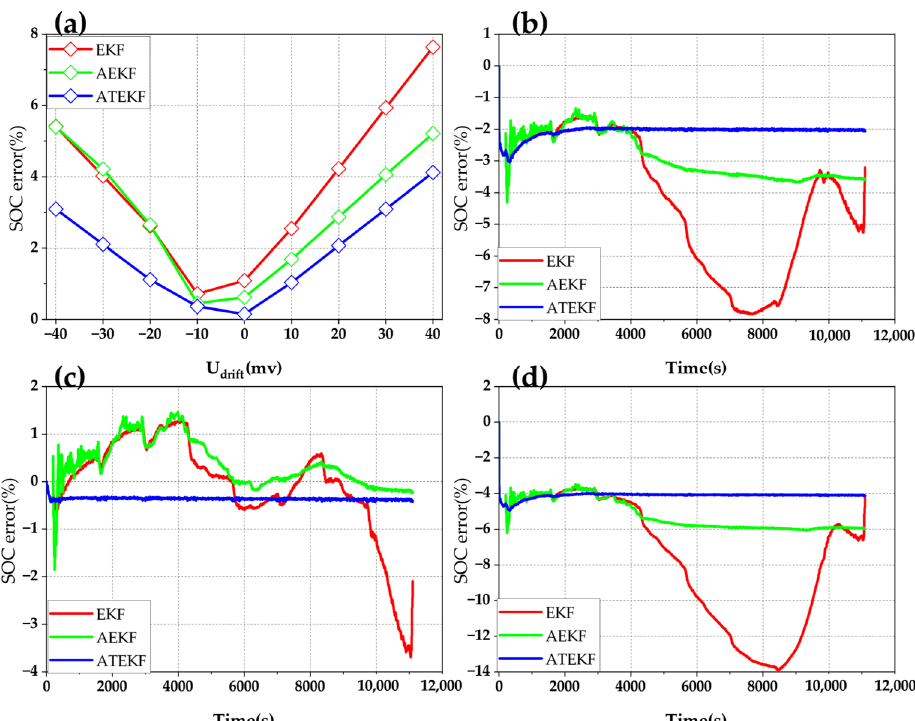
Figure 11. SOC error of three algorithms with voltage drift: ( a ) MAEs of EKF, AEKF, and ATEKF with different voltage drifts; ( b ) SOC error comparison of EKF, AEKF, and ATEKF with 20 mv voltage drift; ( c ) SOC error comparison of EKF, AEKF, and ATEKF with −5 mv voltage drift; ( d ) SOC error comparison of EKF, AEKF, and ATEKF with 40 mv voltage drift.